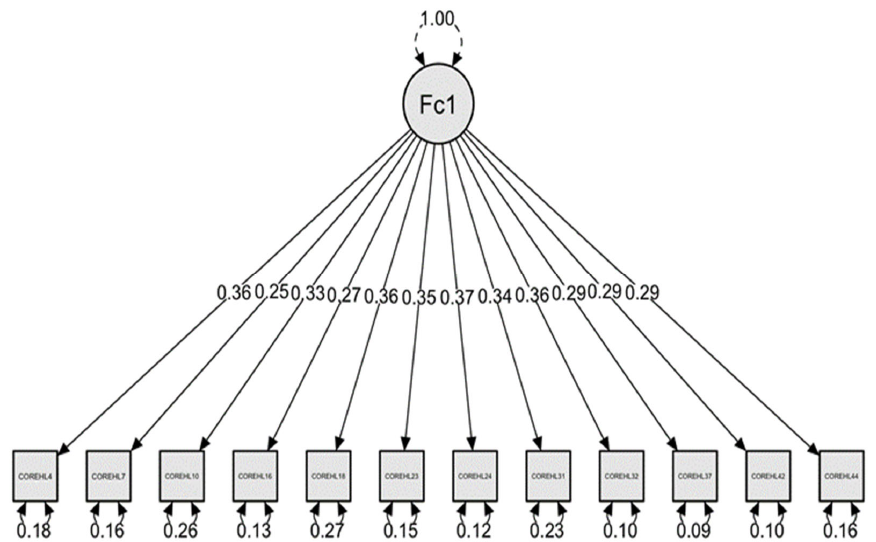
Figure 6. HLS 19 -Q12 model from Confirmatory Factor Analysis. Fc1 is factor one of the scale in the confirmatory factor analysis.